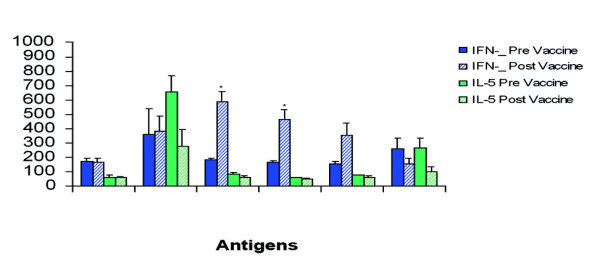
Cytokine responses of ML patients. Peripheral Blood Monocytes of patients were analysed for production of cytokines in vitro when stimulated with different antigens, before and after vaccination. Note the increase IFN-γ production to specific antigens (TSA, LmSTI1 and LeIF) after vaccination.